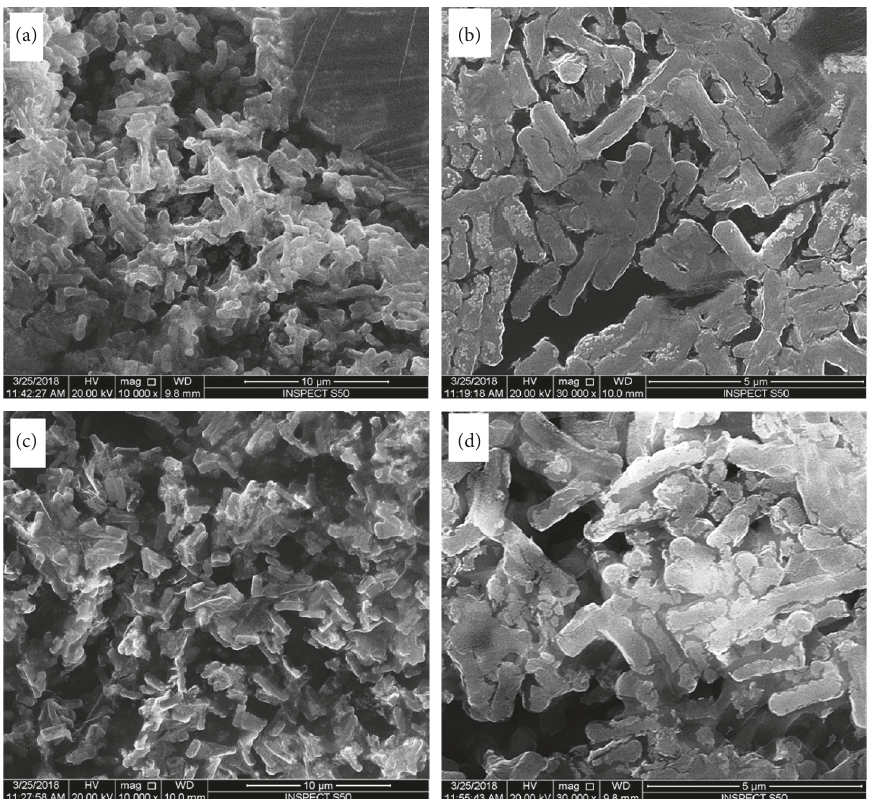
Figure 6: Antibacterial activity of compounds 4b (a, b) and 4c (c, d) against E. coli at 8mg/ml. (a) and (c) are shown at lower magnification and (b) and (d) at higher